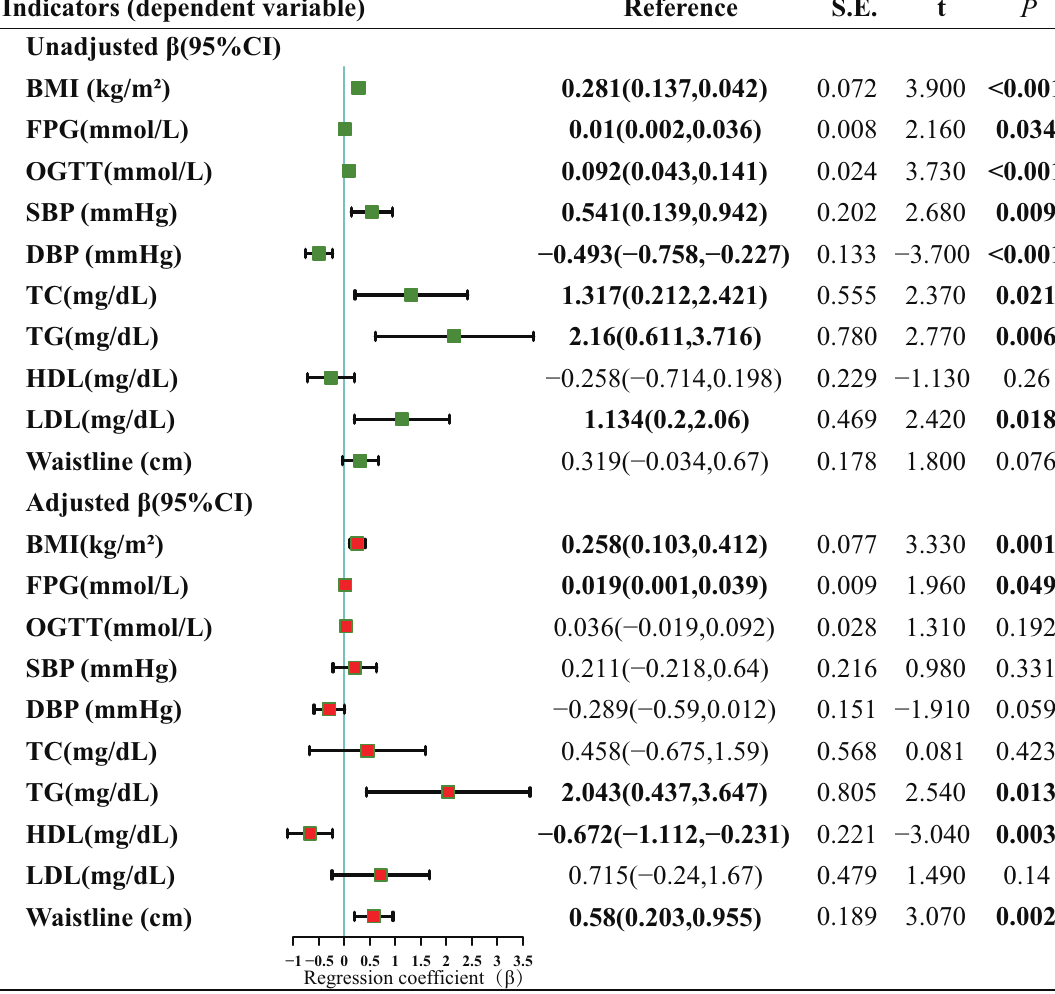
Figure 6. Generalized linear regression analysis of DII levels and indicators of MetS. BMI, body mass index; SBP, systolic blood pressure; DBP, diastolic blood pressure; HDL-C, high-density lipoprotein cholesterol; LDL-C, low-density lipoprotein cholesterol; TC, total cholesterol; TG, total triglycerides; FPG, fasting blood sugar; OGTT, oral glucose tolerance test. Adjusted for confounding factors such as age, gender, race, education, poverty–income ratio, smoking, alcohol consumption, and sedentary behavior. Green: No adjustments were made; Red: Adjusted for confounding